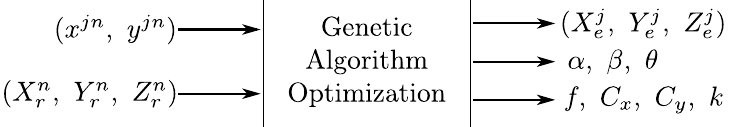
Figure 3. Genetic algorithm used to estimate the IPS